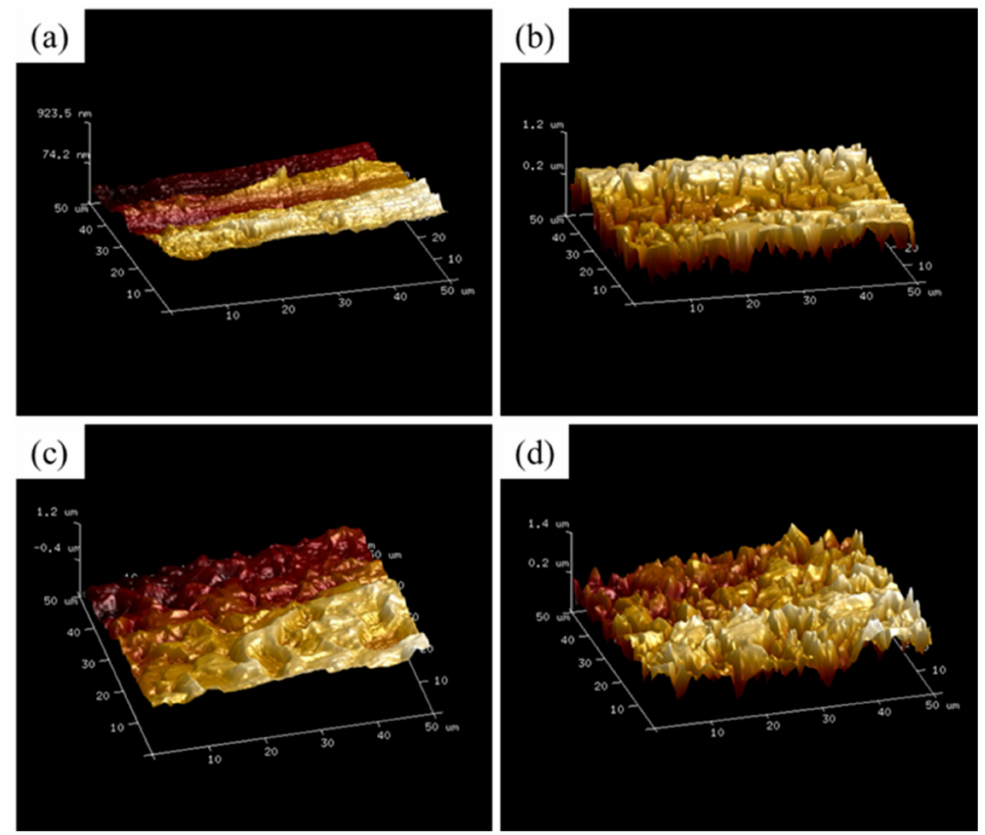
Figure 4. Surface roughness of original and treated SS316L by atomic force microscopy (AFM). ( a ) original SS316L before potentiodynamic tests; ( b ) original SS316L after potentiodynamic tests; ( c ) treated SS316L before potentiodynamic tests and ( d ) treated SS316L after potentiodynamic